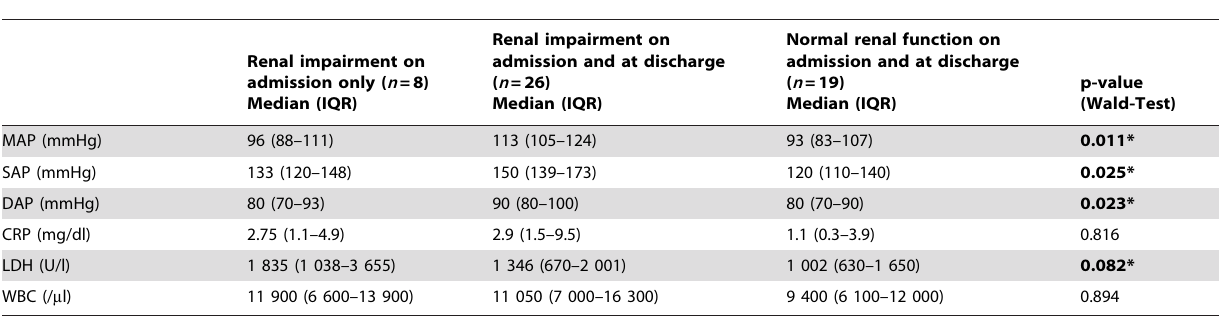
Table 4. Risk factors for renal insufficiency at discharge. Logistic regression analyses, adjusted for renal status on admission.